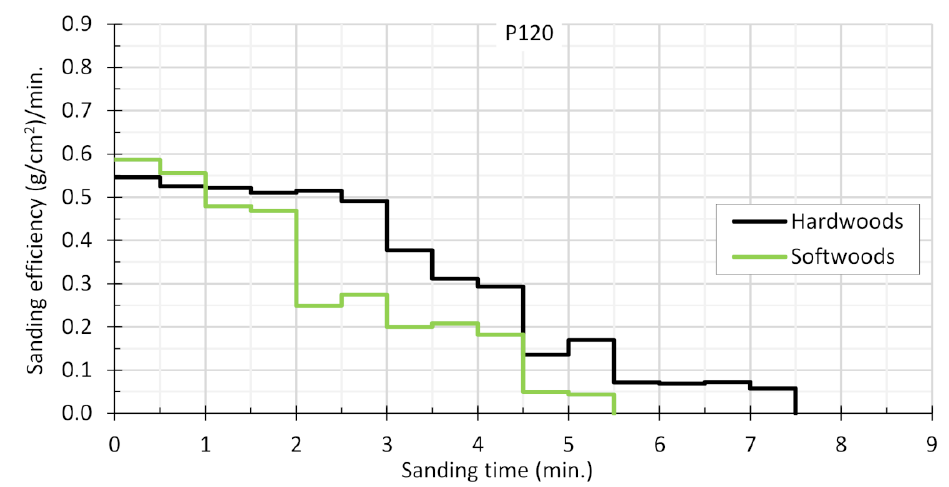
Figure 4. Mean sanding efficiencies of belts with grade P120.